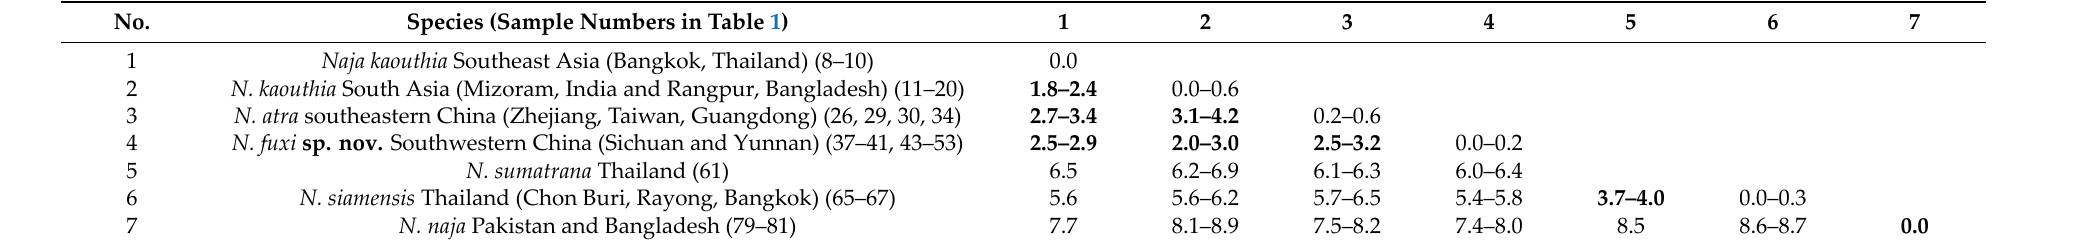
Table 3. Uncorrected P‑distance of subgenus Naja based on COI genes. (Values in